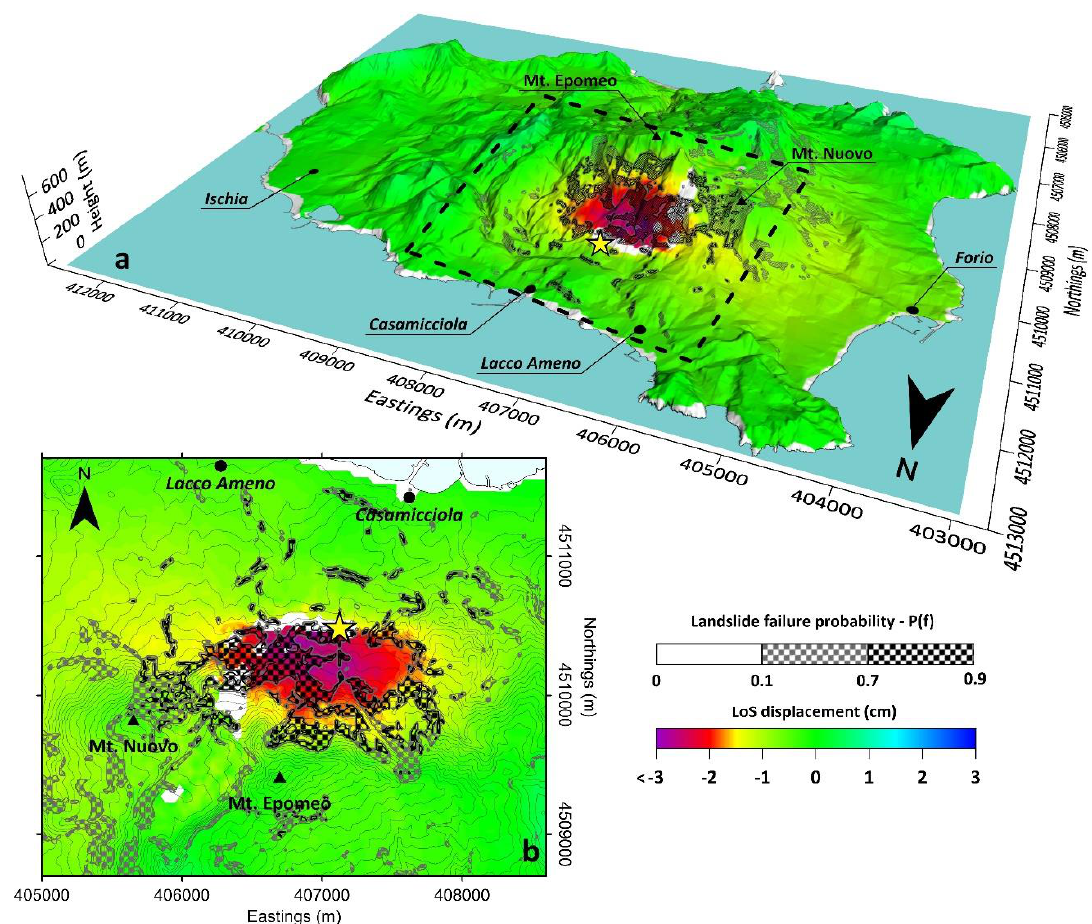
Figure 7. Comparison of spatial patterns of InSAR coseismic ground displacements and landslide failure probability. ( a ) 3D view of Ischia Island; ( b ) detail of the area bounded by the dashed black rectangle in panel a. The color map shows the coseismic LoS displacements from S1 descending data (Figure 4b); The gridded pattern identifies areas with a landslide probability P ( f ) ≥ 70% (black grid) and regions with a landslide probability P ( f ) ≤ 70% (grey grid). Areas with P ( f ) ≤ 10% are not shown. The yellow star identifies the Ischia earthquake epicenter.